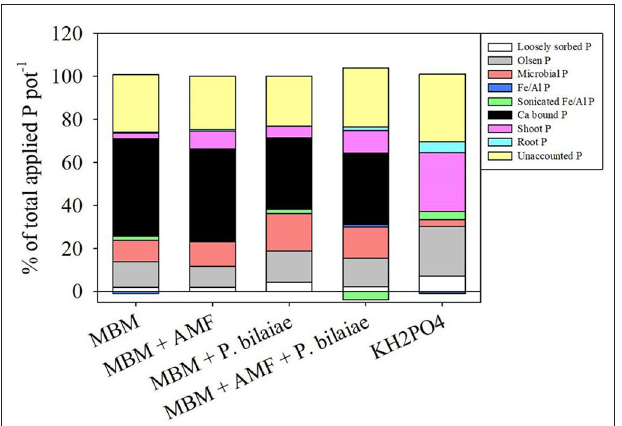
FIGURE 7 | Soil P fractionation (% of total P applied) as affected by different P fertilizers and P mobilizers (arbuscular mycorrhizae fungi (AMF) and P. bilaiae ) at 40 days after planting.